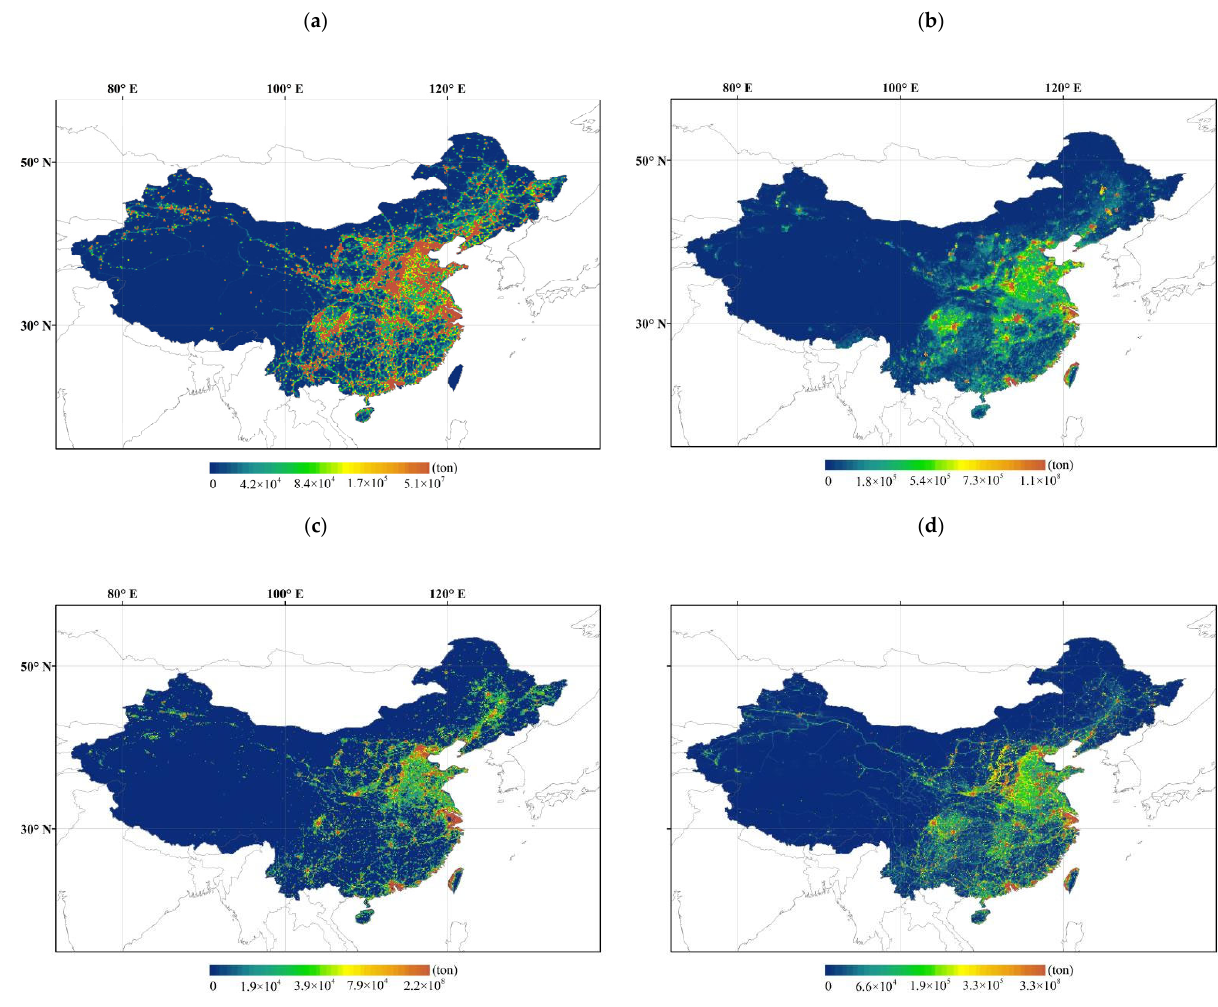
Figure 1. Spatial distribution of the total CO 2 emissions in the year 2012 (0.1 degree grid) for four inventories in China: ( a ) CHRED, ( b ) PKU, ( c ) ODIAC, and ( d ) EDGAR. ODIAC is a gridded CO 2 emission dataset generated by the spatial and temporal dis ‐ aggregation of national emissions from the CO 2 Information Analysis Centre (CDIAC)